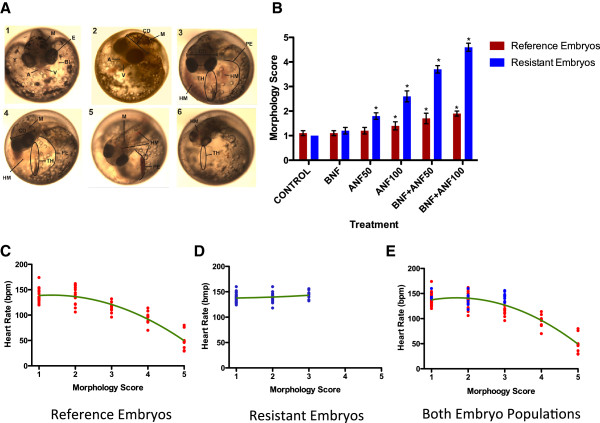
Morphology, morphology scores, and heart rate – morphology correlations of reference and resistant embryos. A) Embryo Morphology: progression of deformities among exposed reference embryos: 1 = control embryo; 2 = 1 μg/L BNF –exposed embryo; 3 = 50 μg/L ANF – exposed embryo; 4 = 100 μg/L ANF – exposed embryo; 5 = 1 μg /L BNF + 50 μg/L ANF – exposed embryo; 6 = 1 μg/L BNF + 100 μg/L ANF – exposed embryo. A – atrium; BI – blood island; E – eye; CD – cranial deformity (reduced cranial width and eye distance, diminished cranial ridges); HM – hemorrhage; M – melanin; PE – pericardial edema; TH – tube heart; V – ventricle; B) Embryo deformity assessment among reference (blue) and resistant (red) embryos under 6 treatments. 2-way ANOVA (p < 0.010 and Bonferroni post-test (p < 0.01) revealed statistical differences in 4/6 treatments between embryo populations. Asterisks (*) represent statistically significant within-treatment differences (Bonferroni post-test, p < 0.05) between Elizabeth River (ER - resistant) and King’s Creek (KC - reference) embryos. C) Correlation between Embryo Morphology and Heart Rate: A) Strong correlation (R2 = 0.82) is apparent among reference embryos; B) No correlation is apparent among resistant embryos (R2 = 0.044); C) Combined data of reference and resistant embryos shows strong correlation between progression of deformities and decrease in heart rates (R2 = 0.78).